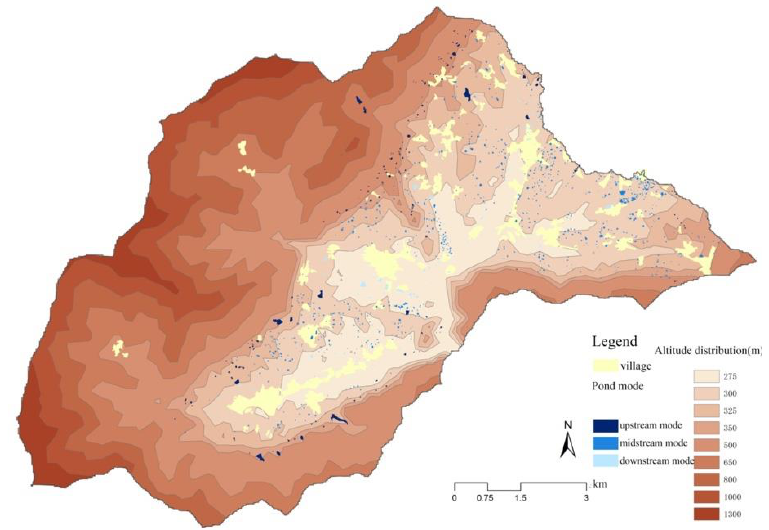
Figure 18. The landscape pattern.